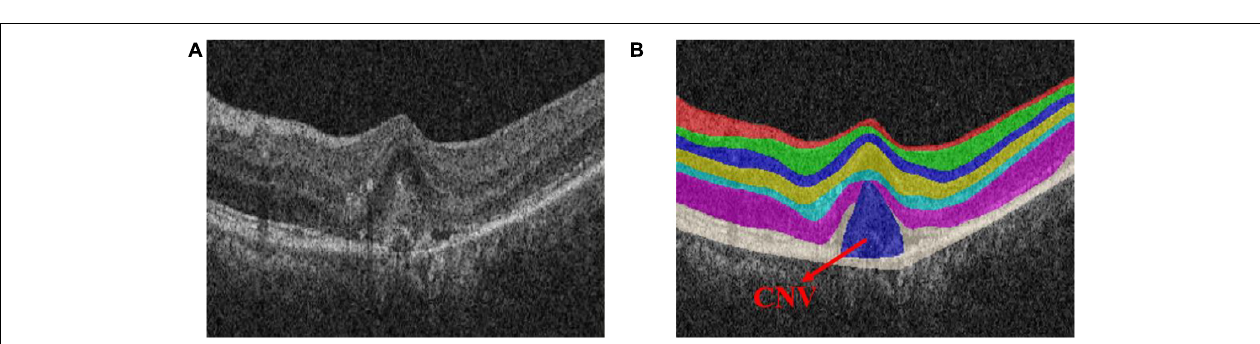
FIGURE 1 | Optical coherence tomography (OCT) image of the normal retinal layer. (A) Original image. (B) Label. NFL , nerve fiber layer; GCL , ganglion cell layer; IPL , inner plexiform layer; INL , inner nuclear layer; OPL, outer plexiform layer; ONL , outer nuclear layer; OPSL , outer photoreceptor segment layer; RPE , retinal pigment epithelium.